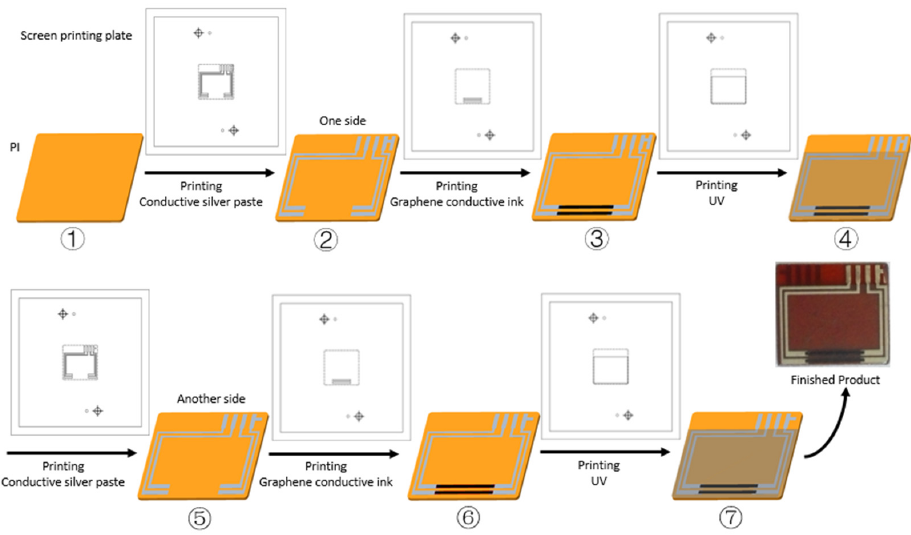
Figure 1. Schematic diagram of the manufacturing process of the sensor, ① PI film; ② Conductive silver paste line on the PI film; ③ Graphene-sensitive grids printed between conductive silver paste line; ④ UV adhesive covered the graphene sensitive grids and most of the conductive silver paste line; ⑤ In another side, conductive silver paste line on the PI film; ⑥ In another side, graphene-sensitive grids printed between conductive silver paste line; ⑦ In another side, UV adhesive covered the graphene sensitive grids and most of the conductive silver paste line. Testing process: Firstly, a cross line should be drawn in the middle of the glass screen, and the center of the two sensitive grids of the sensor was aligned with the center of the